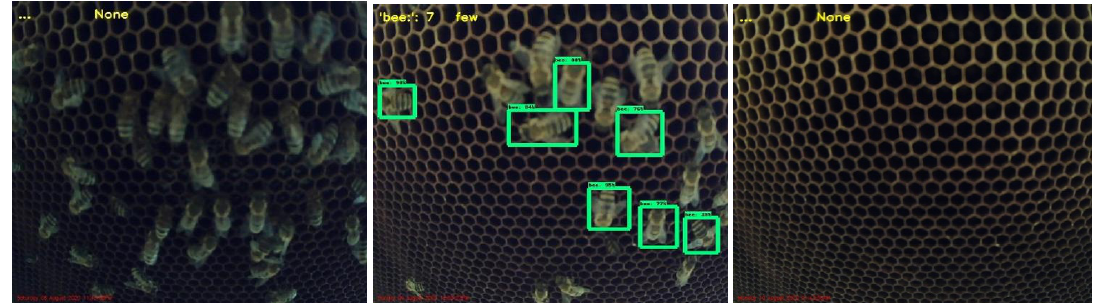
Figure A3. Bee detection with the NVIDIA Jetson Nano using the SSD algorithm, MobileNet v1 model, for Classes 0, 2, and